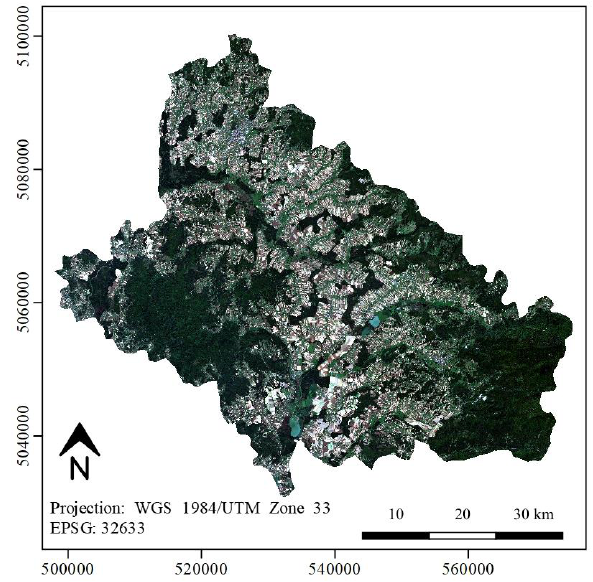
Figure 1. Overview of the Bjelovarsko – Bilogorska County on S2 imagery (“true colour” composite; sensing date: 21-08-2018)